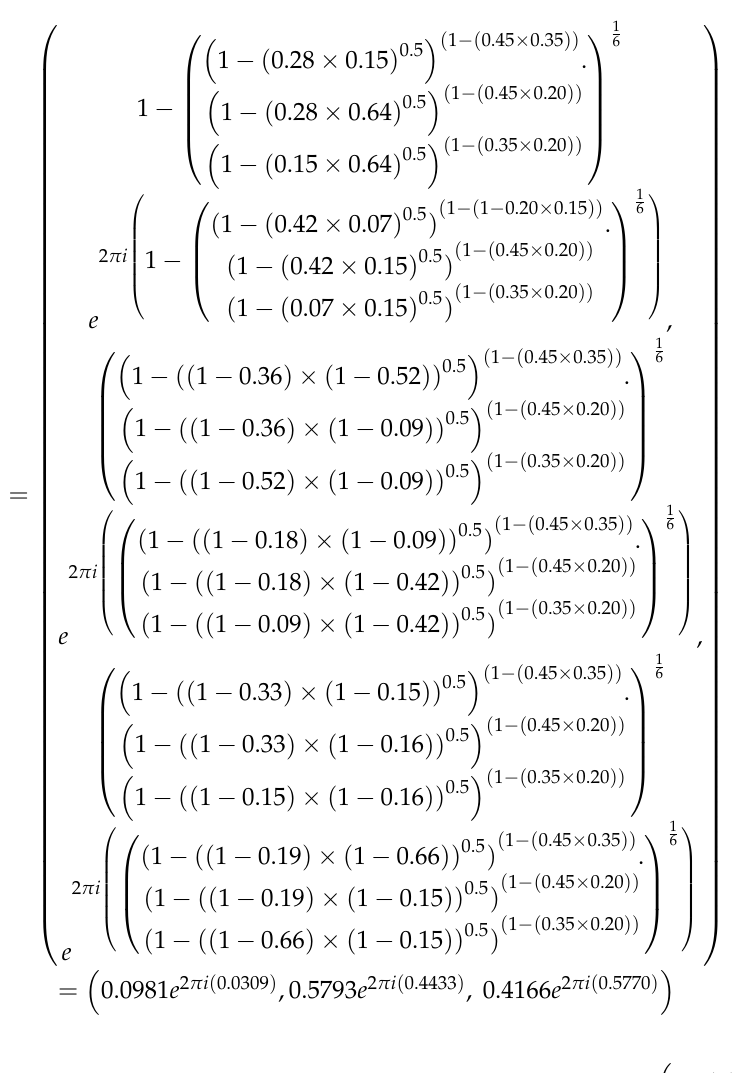
Table 1. Symbols and their meanings.